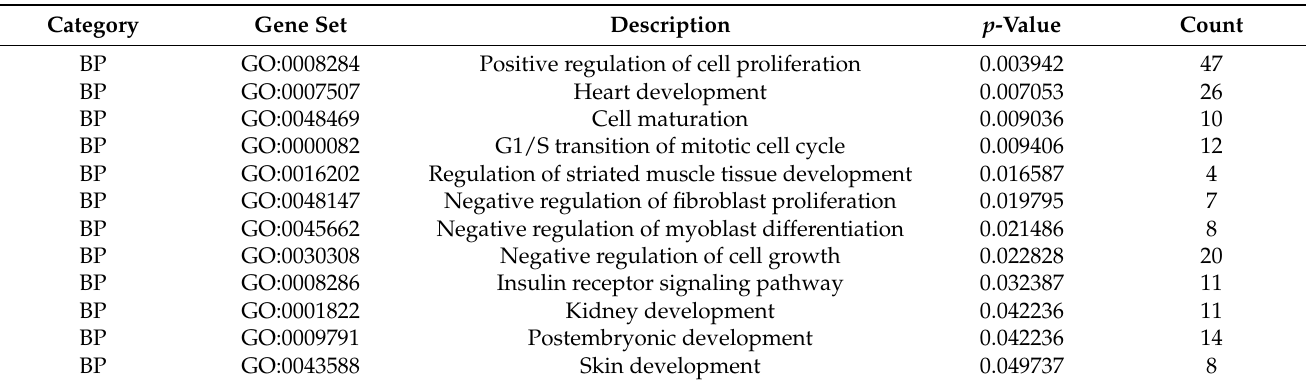
Table 5. Biological processes associated with skeletal-muscle-maturation- and hypertrophy-related DEGs in Sus scrofa .